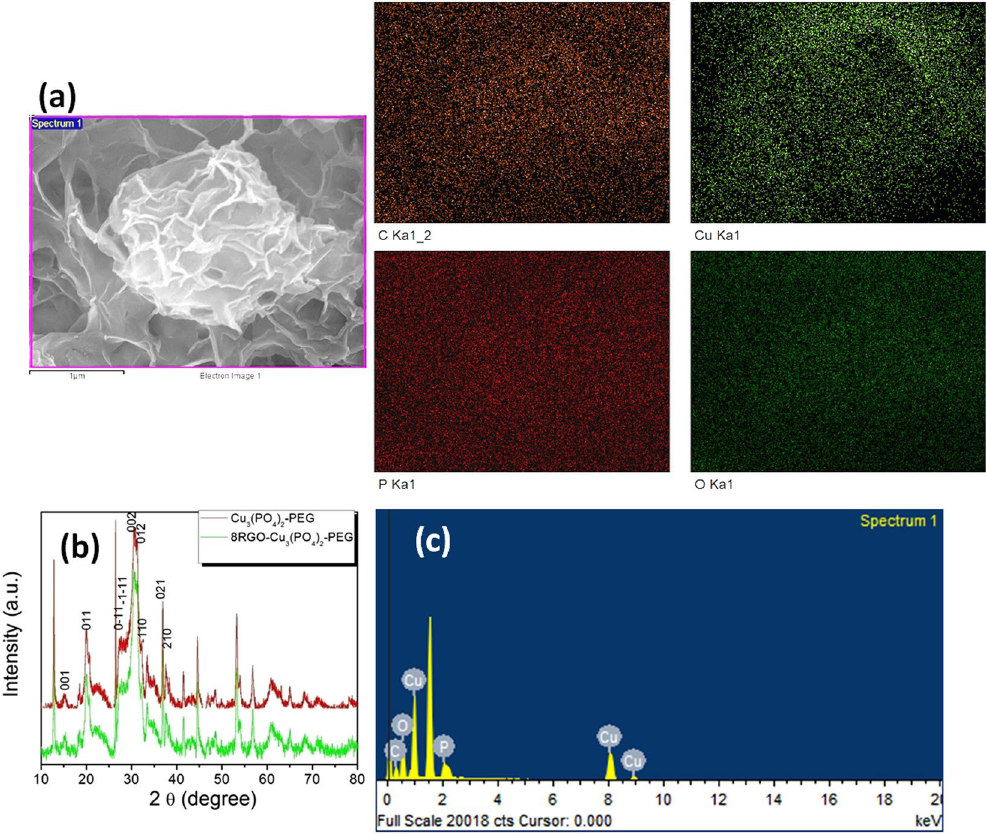
Figure 3. ( a ) The x-ray mapping of elements present in 8RGO-Cu 3 (PO 4 ) 2 -PEG. ( b ) XRD pattern of 8RGO- Cu 3 (PO 4 ) 2 -PEG and Cu 3 (PO 4 ) 2 -PEG samples. ( c ) EDX data of 8RGO-Cu 3 (PO 4 ) 2 -PEG collected by rastering the incident electron beam on the selected area with elemental